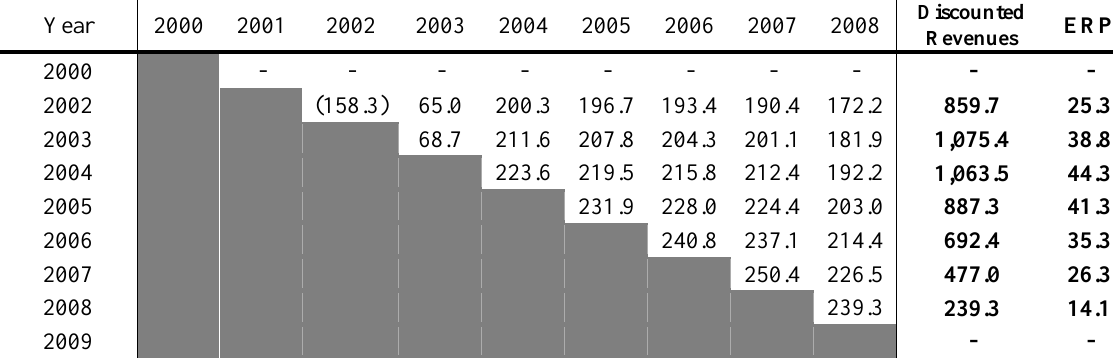
Table 5. Political risk premiums (million